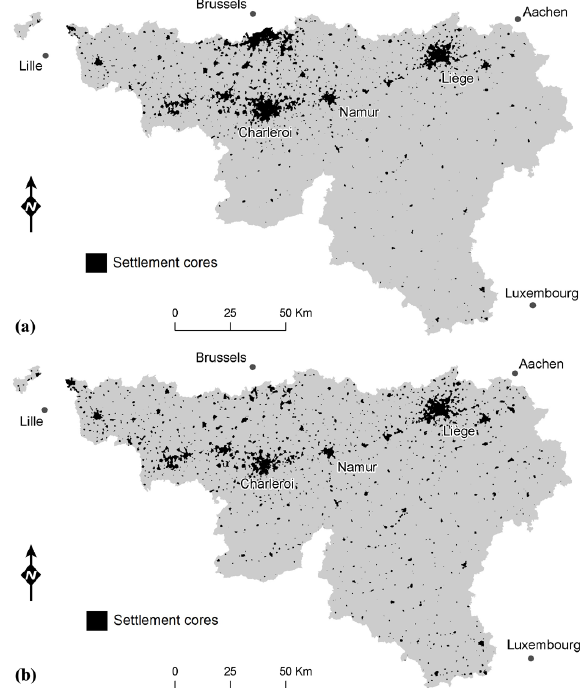
Fig. 12. Delimitation of the settlement cores in the two subsets of dense urban development scenarios: regional (a) and local (b) development scenarios. At this stage, neither the exclusion areas nor the high or moderate flood hazard areas were subtracted from the settlement cores in order to improve map